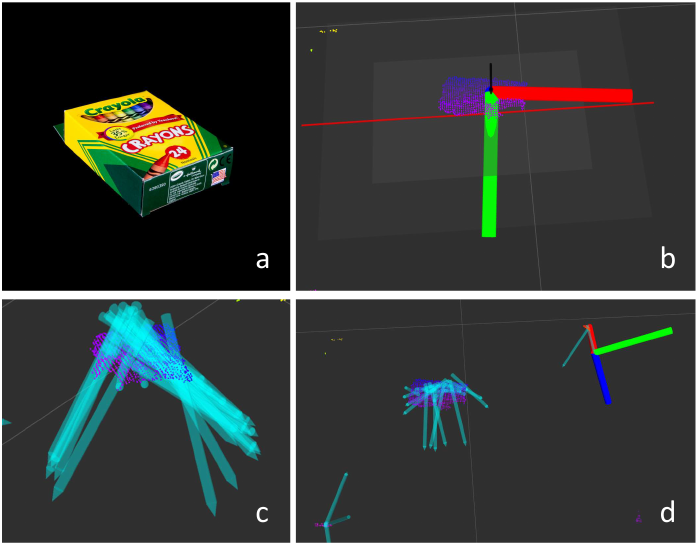
Figure 12. Robustness comparison of AGILE and HAF for the crayons box ( a ). Results for HAF ( b ) and AGILE ( c , d ) are